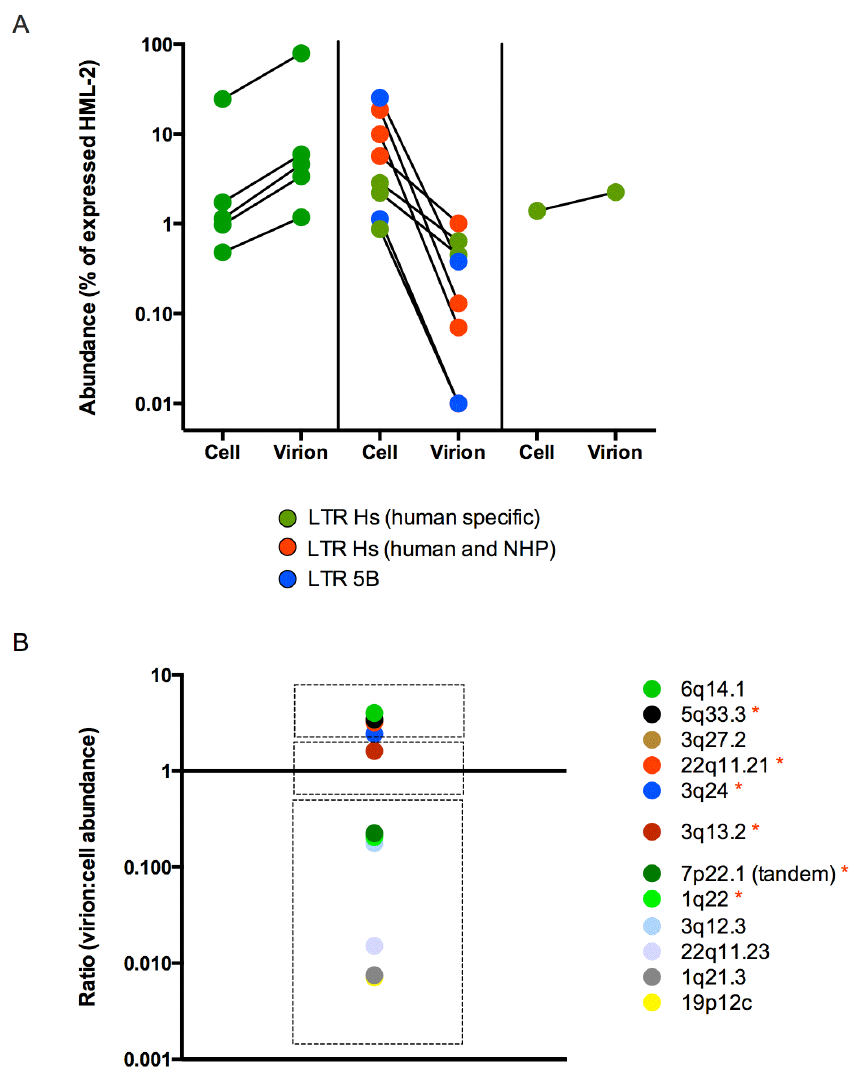
the LTR 5B provirus at chromosome 4p16.3a, expressed in cells at about 1%, were not even detected in the virions. Other transcripts with major decreases, on chromosomes 1q21.3, 3q12.3 and 19p12, were derived from older LTR Hs integrations.